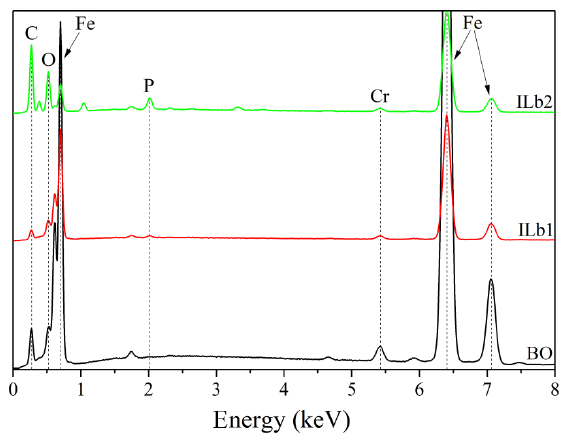
Fig. 10 EDS spectra with elemental (at%) characterized from inside the friction test wear track of BO, ILb1, and ILb2 at 120 °C.